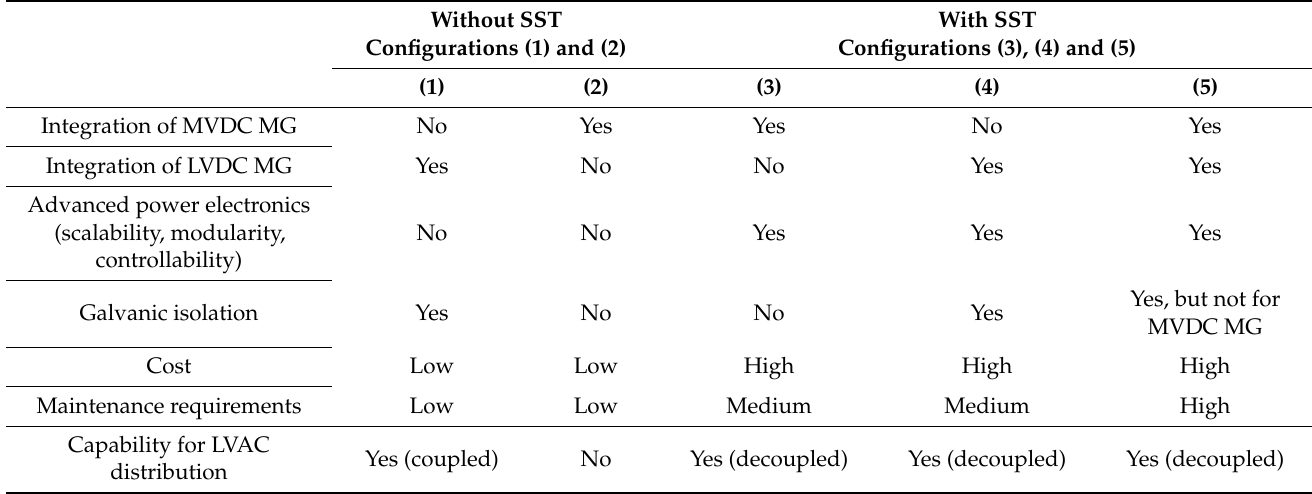
Table 2. Evaluation of interfaces (Data from